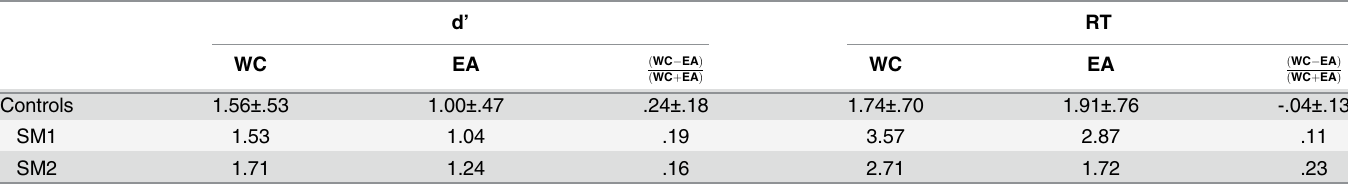
Table 4. Results for Experiment 4: Other-race